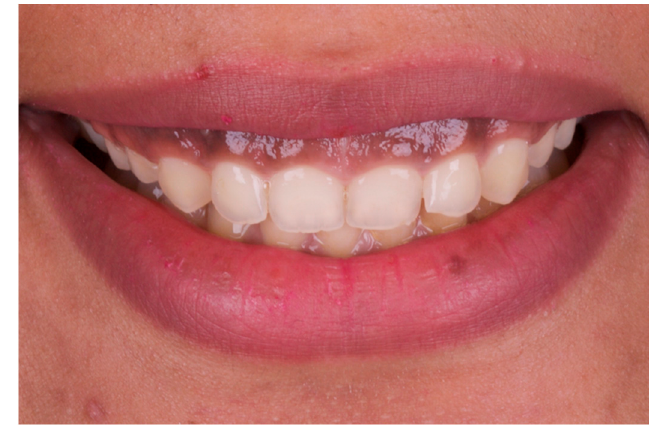
Figure 1. Preoperative smile view showing excessive gingival display.